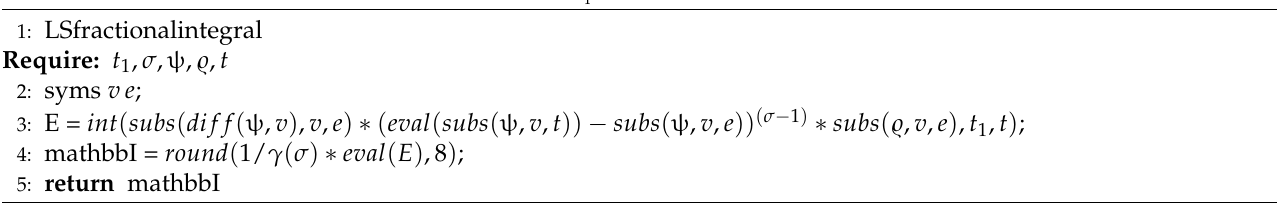
Algorithm A1 MATLAB lines for the calculation of I σ ; ψ